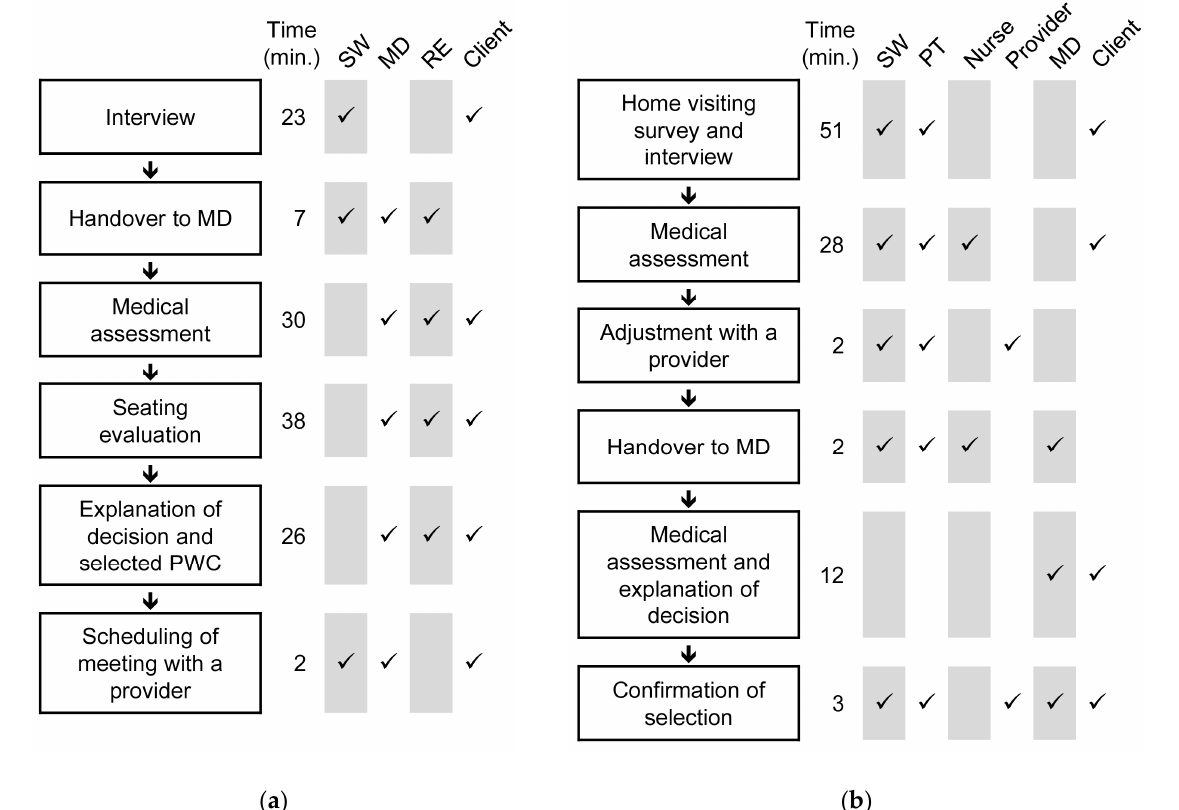
( a ) ( b ) Figure 1. Recorded processes in the pseudo setting. The phase descriptions, the duration thereof, and participants for RCC A ( a ) and B ( b ) are depicted.